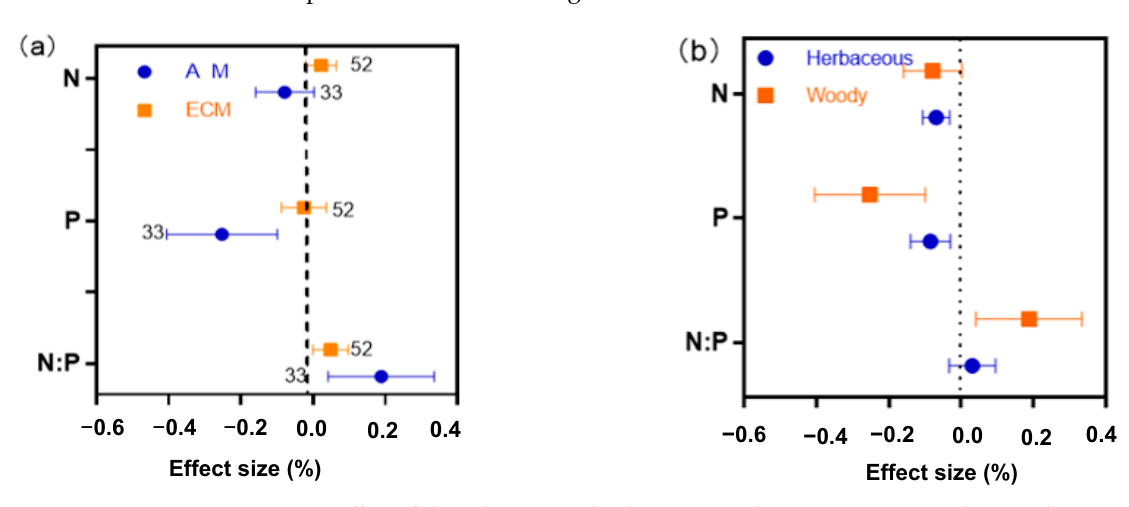
Figure 3. Effect of drought on woody plant N, P, and N:P ratio in AM and ECM plants ( a ), and N, P, and N:P ratio in herbaceous and woody AM plants ( b ).